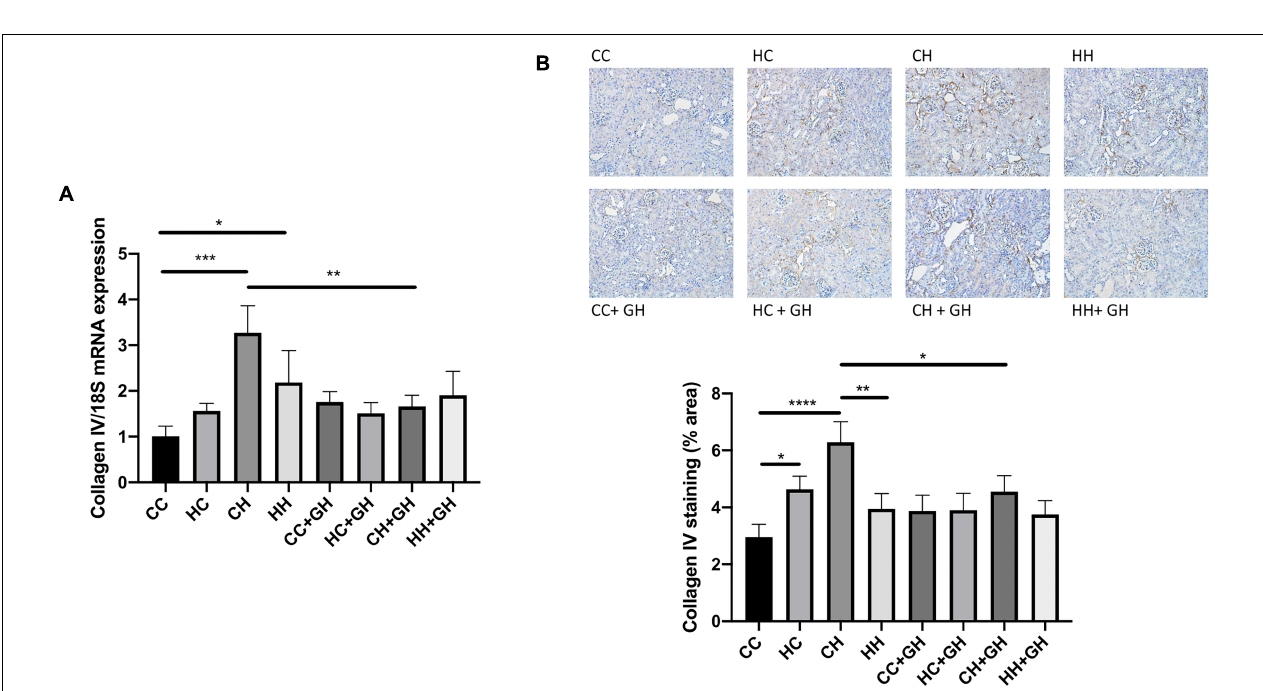
FIGURE 7 | Renal fibrotic changes as measured by collagen IV. (A) mRNA expression of collagen IV, (B) representative images of collagen IV staining at 200 × magnification, and quantitation. Results expressed as mean ± SEM, n = 6. * p < 0.05, ** p < 0.01, *** p < 0.001, **** p < 0.0001. CC, control offspring; HC, lean offspring of obese mothers; CH, obese offspring of lean mothers; HH, obese offspring of obese mothers; CC + GH, control offspring exposed to gestational hydralazine; HC + GH, lean offspring of obese mothers with gestational hydralazine; CH + GH, obese offspring of lean mothers with gestational hydralazine; HH + GH, obese offspring of obese mothers with gestational hydralazine.